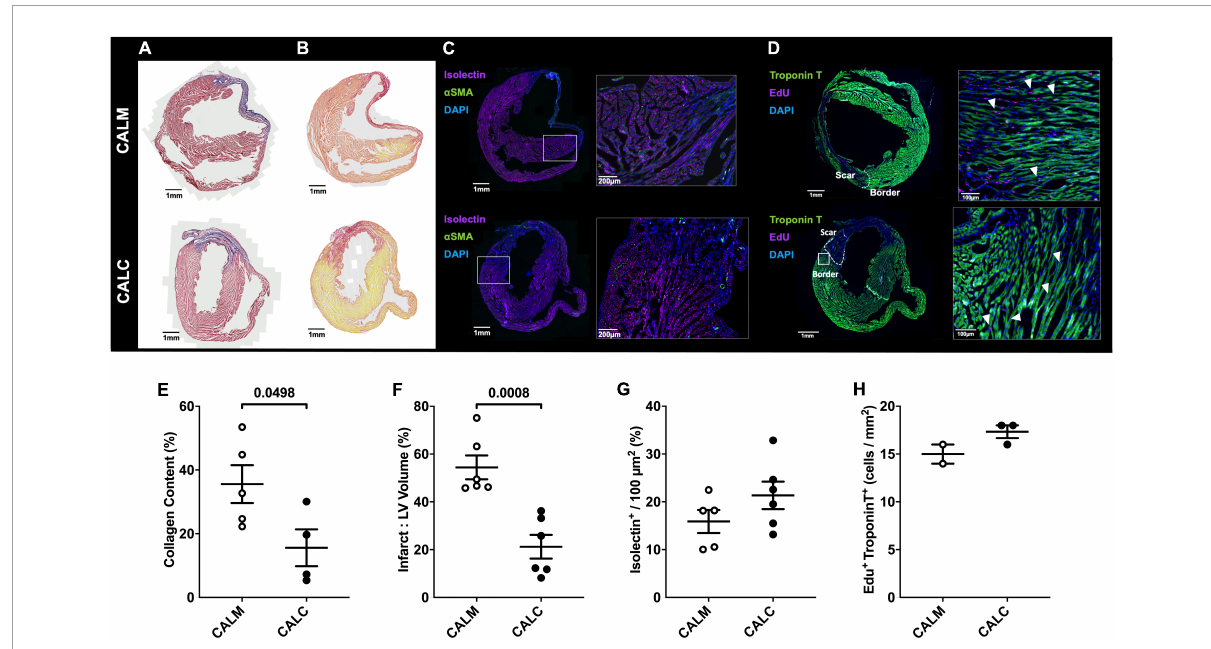
FIGURE5 Immunohistochemical assessment of mature infarct area and myocardial characteristics. Collagen deposition (A,E) and infarct volume (B,F) were significantly reduced in CALC mice compared with CALM. There were no differences in isolectin B4 perfused vascular density (C,G) or myocardial regeneration (D,H) between the groups. Student’s t -test; data are mean ± SEM. White arrows (D) indicate Edu + Troponin T +